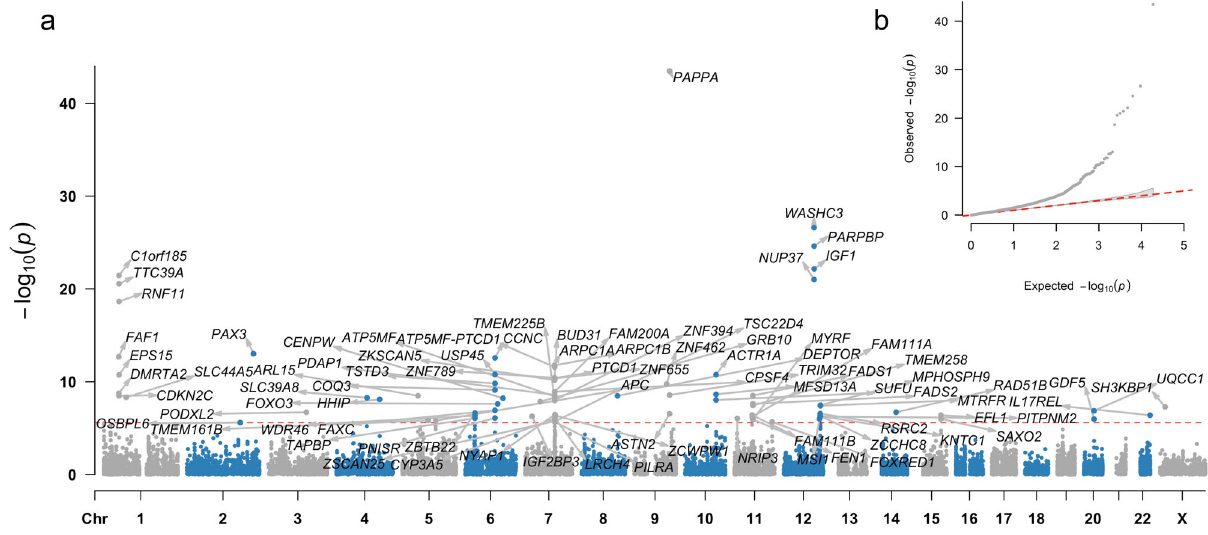
Fig. 2 Gene-based GWAS of cerebellar volume identi fi es 85 genome-wide signi fi cant genes. a Manhattan plot of − log10( P ) values from the gene-based GWAS for cerebellar volume in MAGMA. b Quantile – quantile (QQ) plot of − log10( P ) values from gene-based GWAS of cerebellar volume.